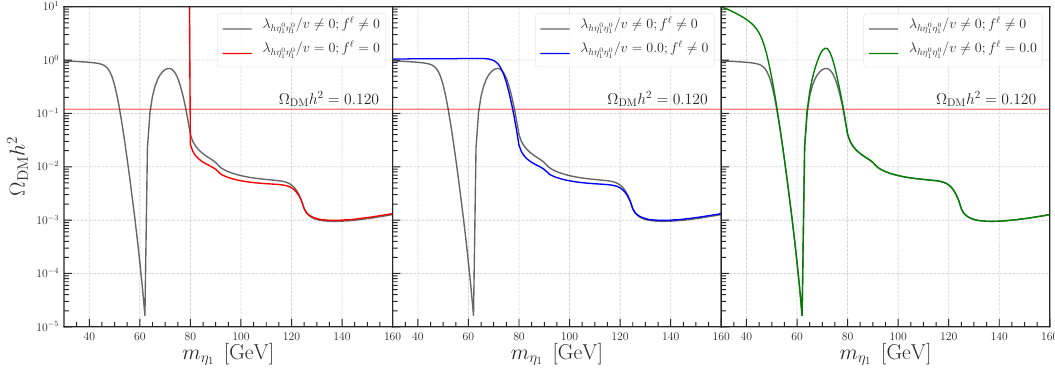
Figure 5 . Contributions of di(cid:11)erent processes shown in (cid:12)gure 4 to the DM relic density in the model with Y D = 1 as a function of the DM mass m (cid:17) . The grey curves show the case for the benchmark 1 parameter set with the mass spectrum ( m (cid:17) ; m (cid:17) ; m ; M (cid:31) ; M (cid:31) ) = (380 ; 200 ; 200 ; 1100 ; 600) GeV (cid:17) (cid:6) 2 e (cid:22) A and the coupling strengths ( f e ; f (cid:22) ; (cid:21) =v ) = (0 : 1 ; 0 : 2 ; 0 : 01). From the left to right panels, the h(cid:17) 0 1 (cid:17) 0 1 colored curve shows the case with some of the couplings taken to be zero, by which we see the impact of the contribution from the process of (b), (b) plus (c) and (a) plus (b) shown in (cid:12)gure 4. dominant process. It is clear from the central plot that for m (cid:17) < 50 GeV, the relic density 1 is dominated by the t -channel annihilations into electron and muon pairs. The rightmost plot shows that the Higgs-mediated s -channel process is most important around the Higgs resonance when m (cid:17) 62 : 6 GeV. We observe that for m (cid:17) < 150 GeV, there are 1 (cid:24) 1